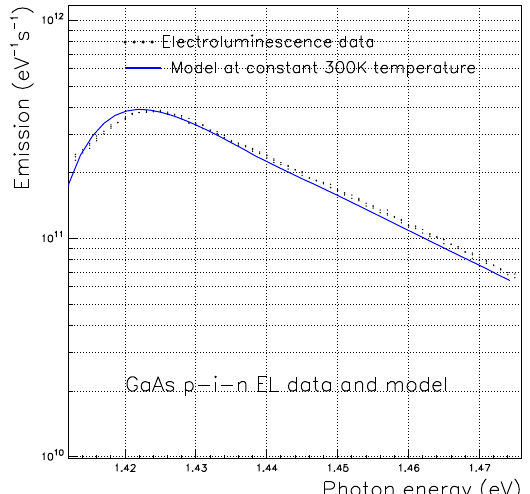
Fig. 2. Experimental (dots) and theoretical (line) luminescence of a bulk p-i-n solar cell showing a good fi t with the experimental applied bias for standard temperature of 296 K.